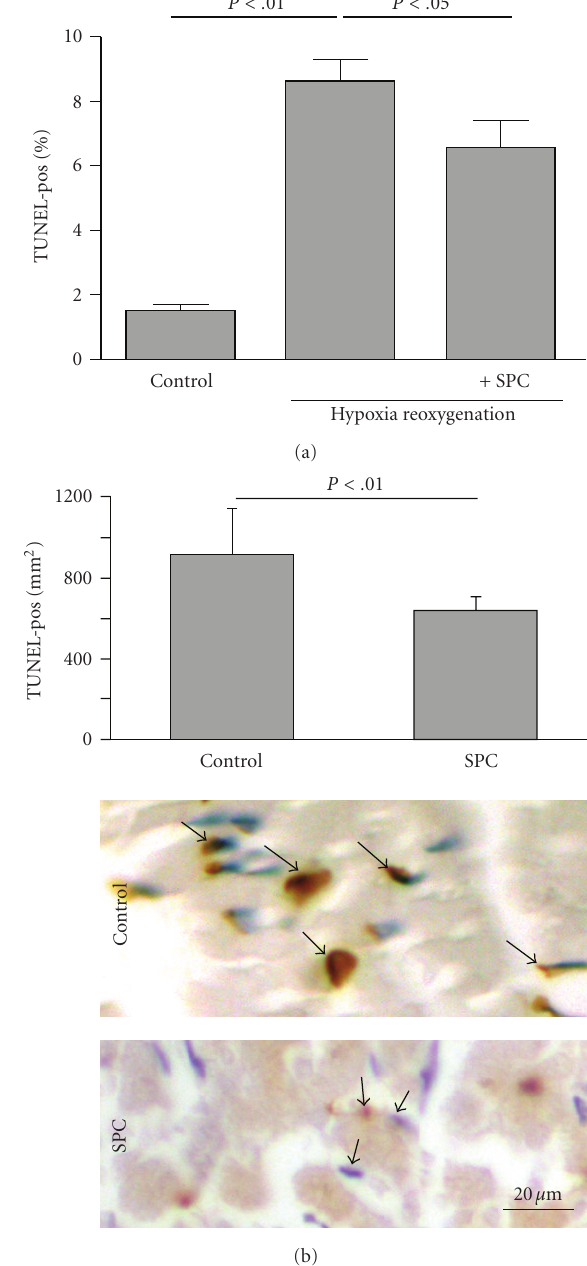
Figure 3: SPC inhibits apoptosis of cardiomyocytes in vitro and in the infarction in vivo . (a) Quantification of TUNEL-positive nuclei in rat neonatal cardiomyocytes after simulated ischemia/ reperfusion in the presence or absence of 10 μ M SPC. (b) Represen- tative terminal dUTP nick end-labeling (TUNEL) staining in the area at risk (outside the TTC-positive area) of control and SPC- treated mice 24 hours after ischemia/reperfusion. Morphometric quantification is presented